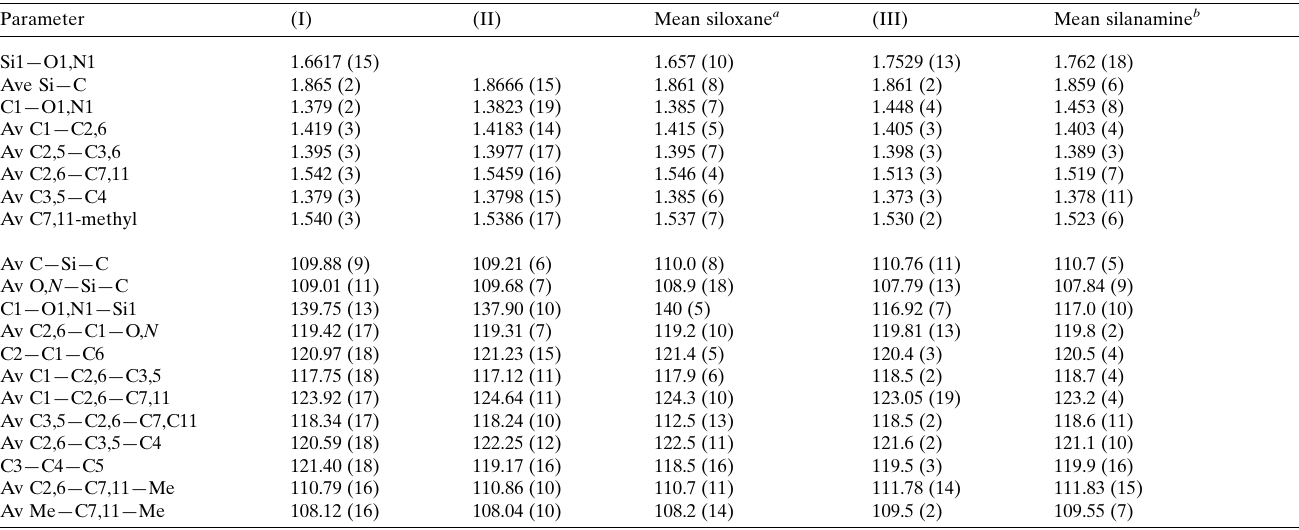
Table 1 Average interatomic distances and angles (A˚ , (cid:3) ) in (I), (II) and (III) with comparators. Atom numbers taken from